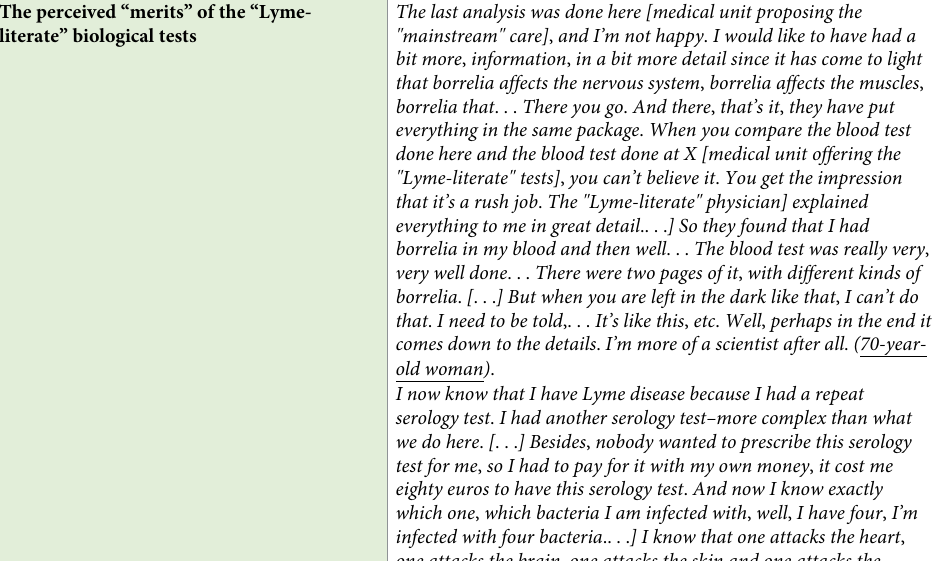
Table 5. The representations of chronic Lyme disease